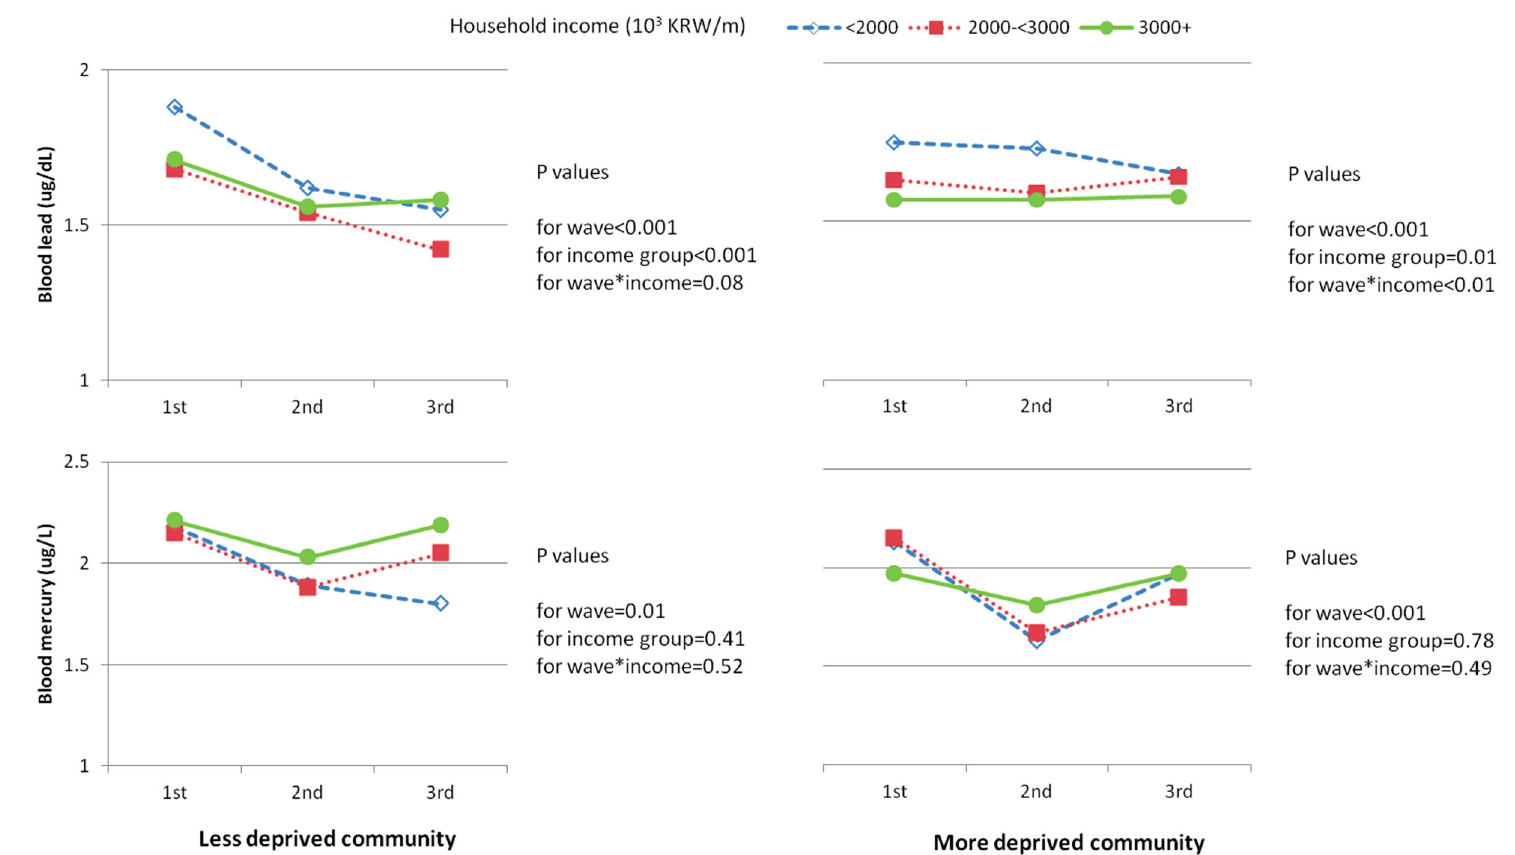
Figure 2. Follow-up trends of blood lead and mercury level by individual and community SEP in 2281 children, CHEER, Korea, 2005–2010; The 1st , 2nd and 3rd waves performed for years of 2005–2006, 2007–2008, and 2009–2010, respectively; Household income; lowest group <2000, middle group 2000–2999, highest group ≥ 3000 × 10 3 KRW per month; Deprivation index (DI) of the community was calculated from household overcrowding, male unemployment rate, head of family in low socioeconomic position, house ownership, and substandard living resources based on data from the 2005 Census. Less deprived community: DI ≤ 1.00. More deprived community: DI > 1.00. Geometric mean levels for blood metal were calculated using the mixed model after adjusting for age, gender, child’s weight, residential area, second hand smoke, survey year, hour for playing outside (for blood lead), fish consumption frequency per week (for blood mercury), and baseline blood metal